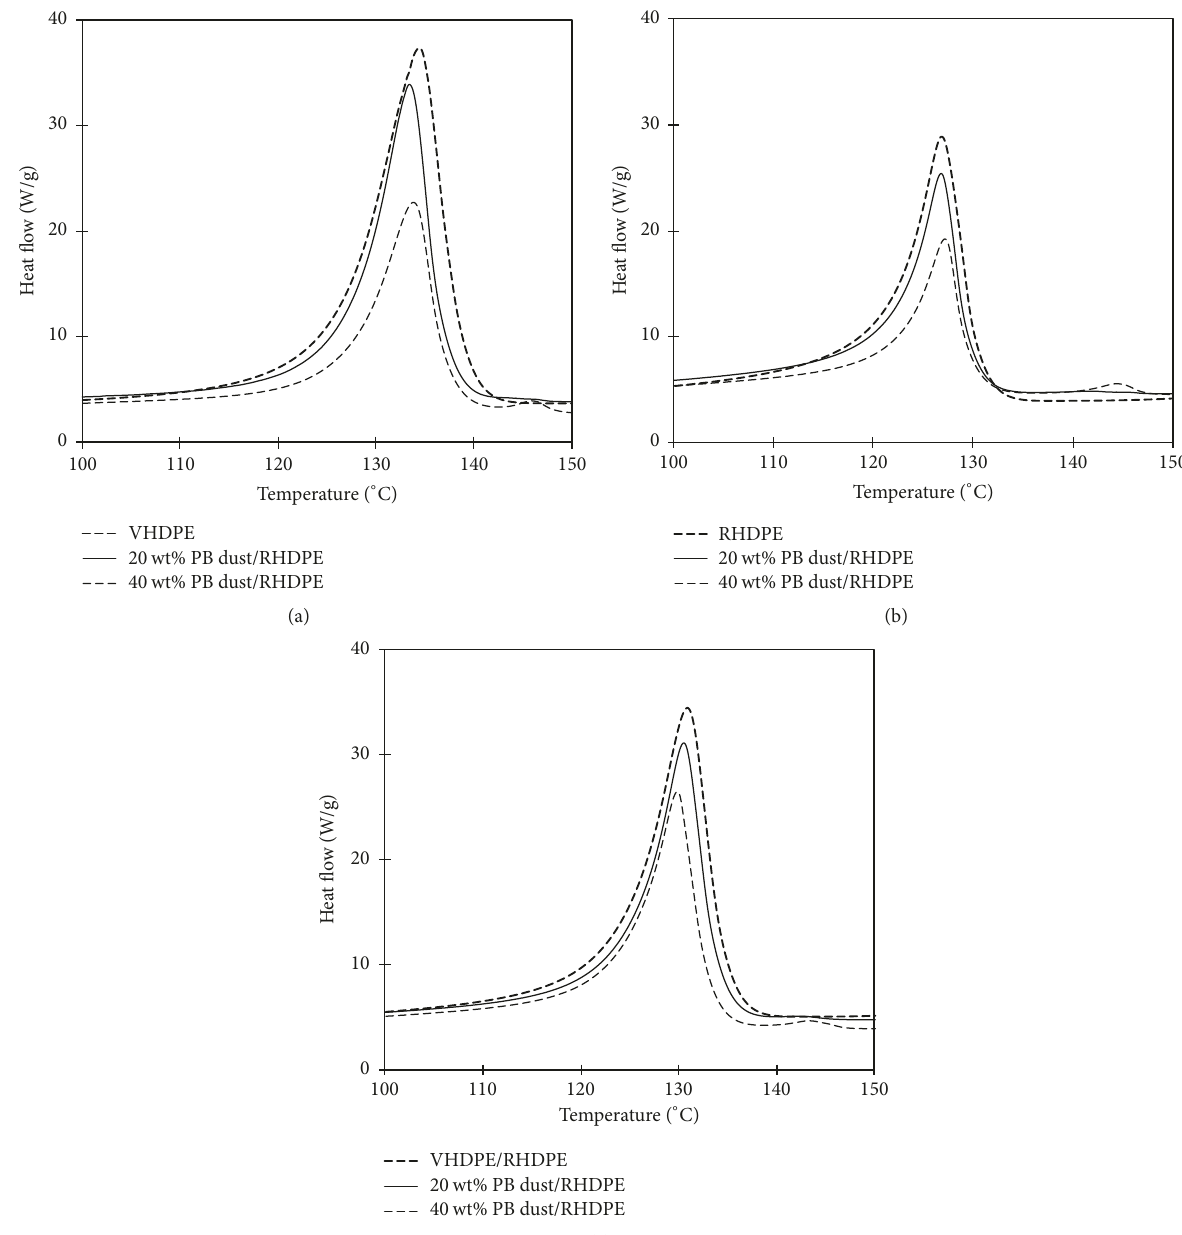
Figure 3: DSC curves of (a) PB dust/HDPE, (b) PB dust/RHDPE, and (c) PB